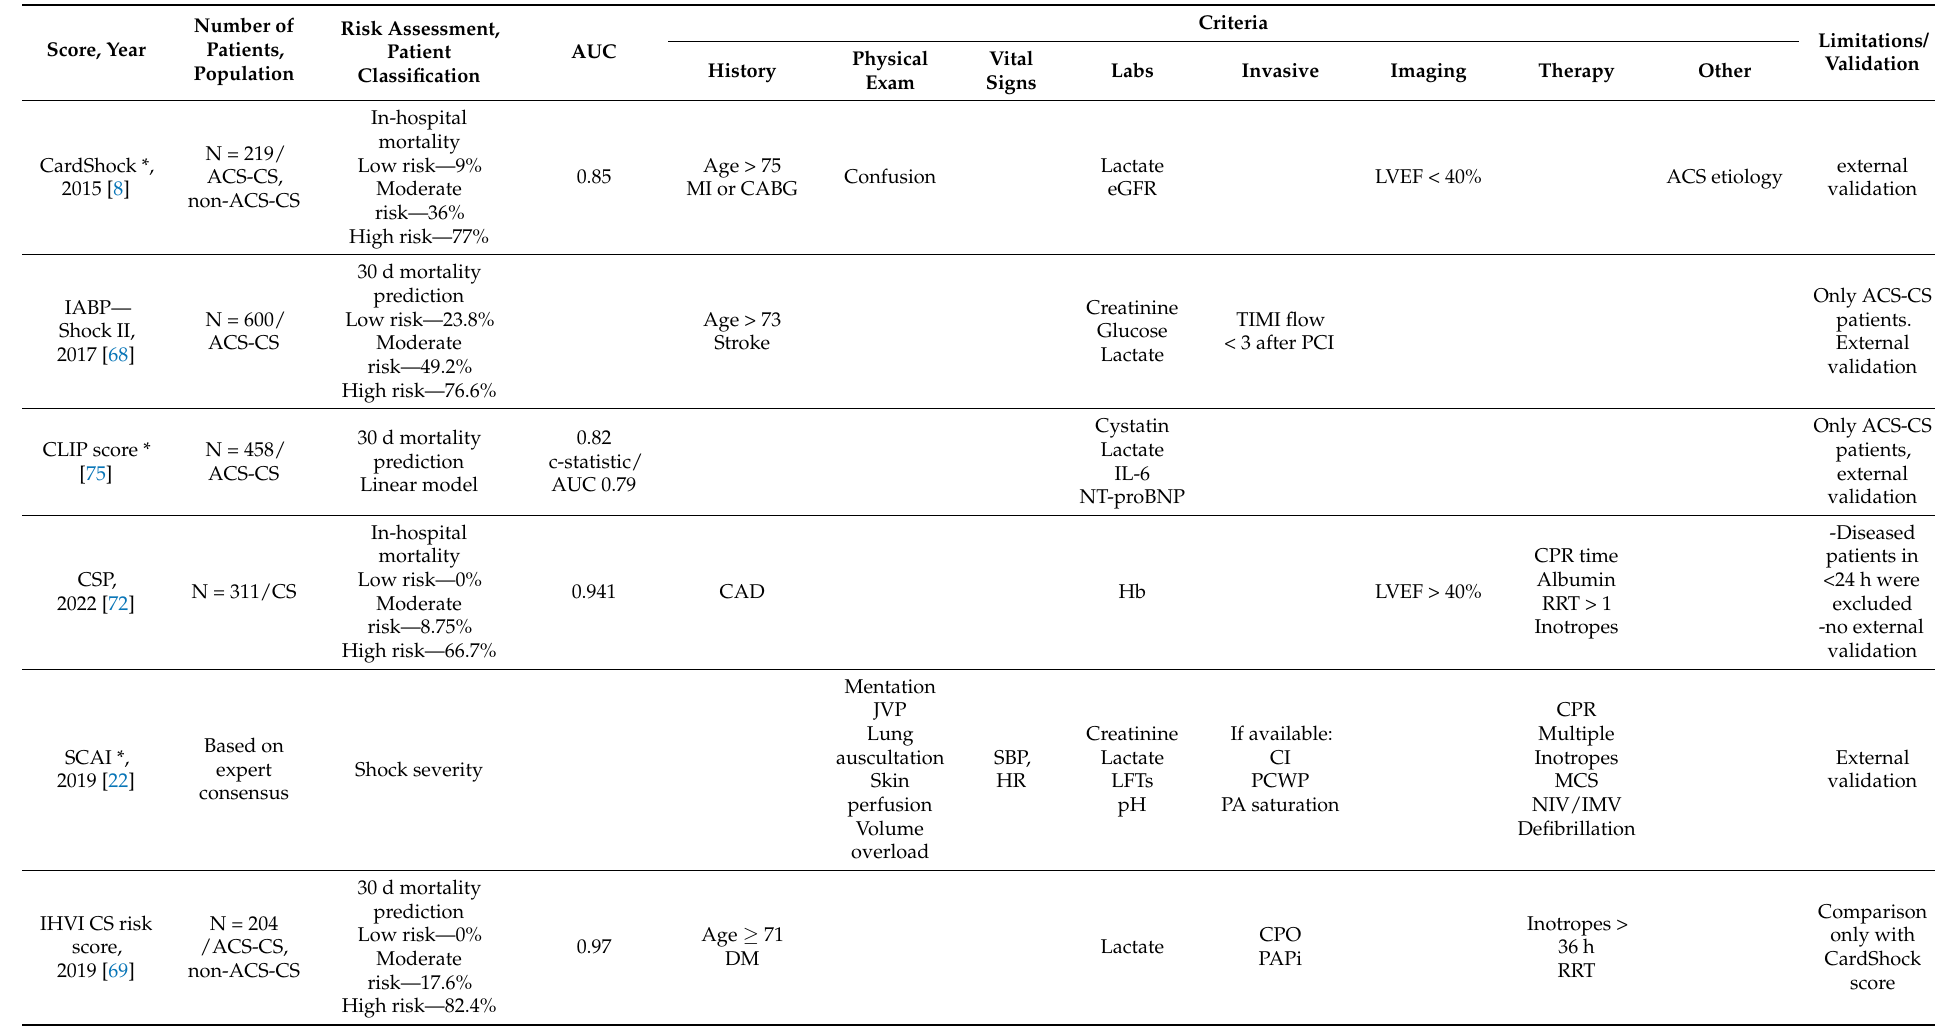
Table 2. Useful risk scores for the risk stratification of cardiogenic shock (CS) patients. Risk scores highlighted with * could be used in the Emergency